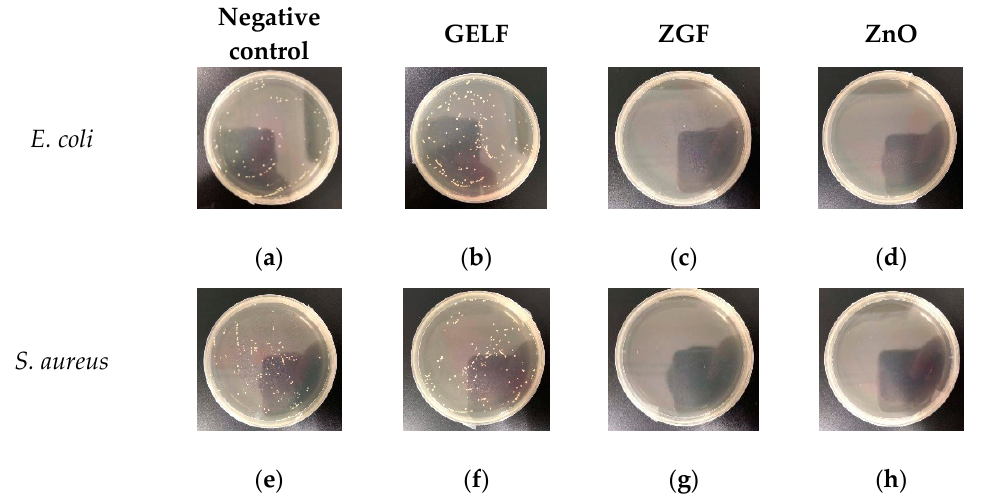
Figure 9. The photographs of antibacterial activities of negative control, GELF, ZGF and ZnO (positive control) to E. coli ( a – d ); to S. aureus ( e – h ).